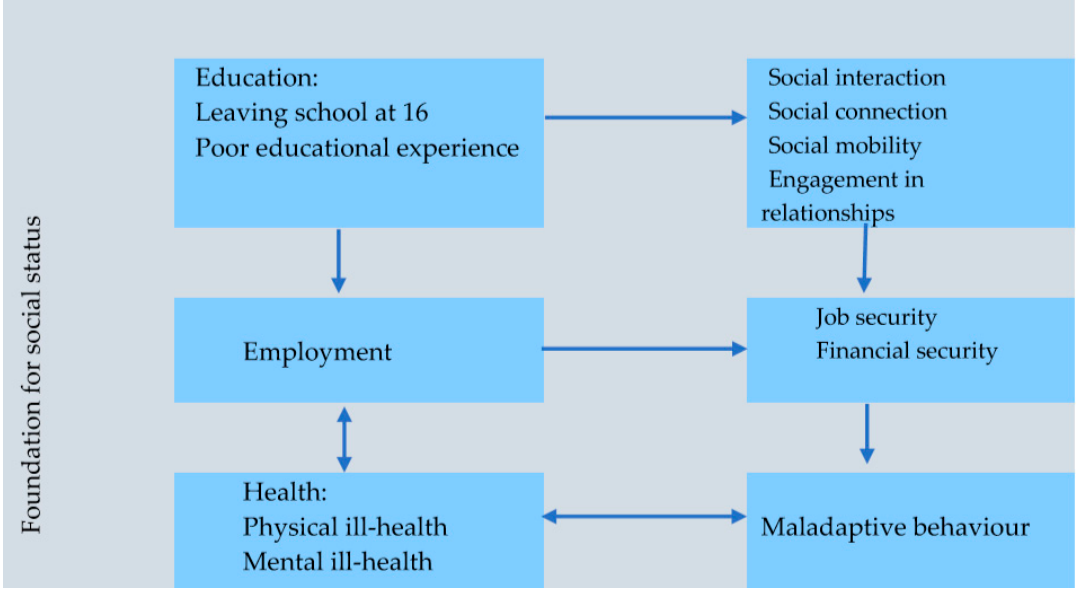
Figure 2. Illustrates participants’ perceived role of education, employment, and health in shaping the conditions that led to their low social